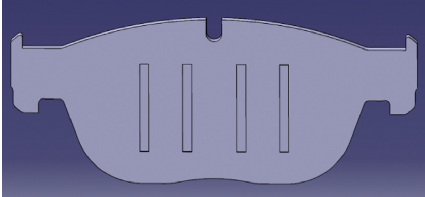
Figure 9: Sample 4 (four longitudinal slots).